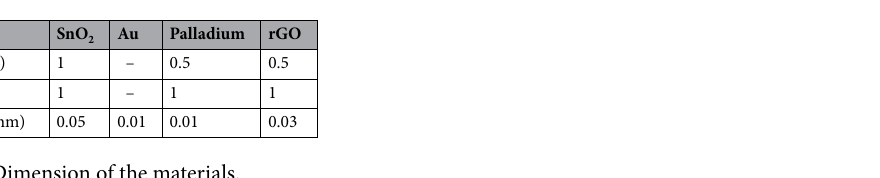
Table 1. Dimension of the